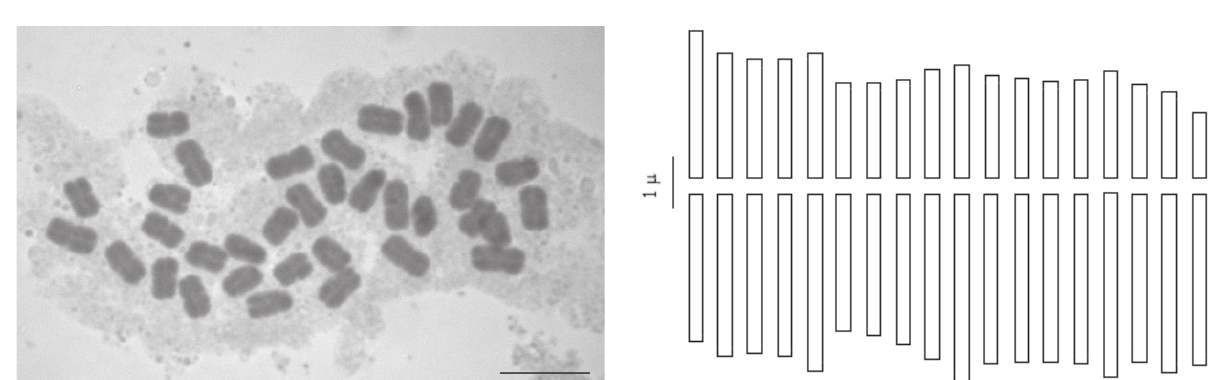
Figure 3. Somatic metaphase in A. fragrans (2 n =36), and haploid idiogram (Scale bars: 1